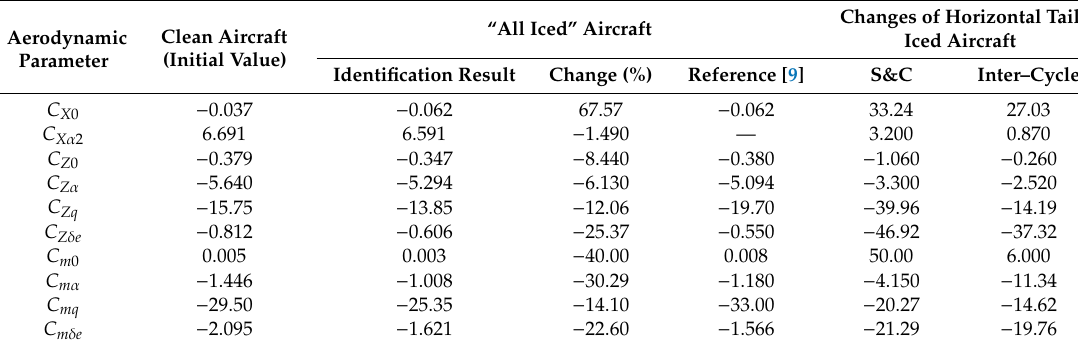
Table 8. Identification results of artificially iced